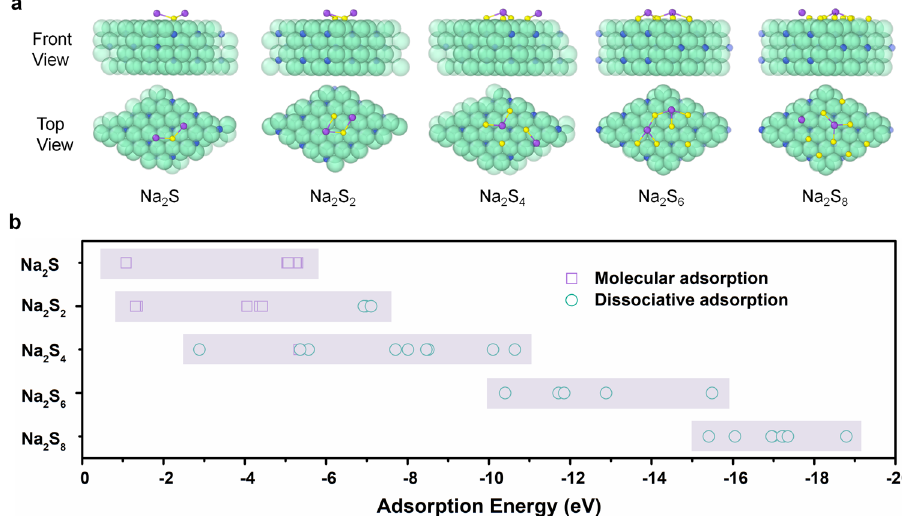
Fig. 3 DFT calculations on the adsorption properties of Fe 3 N. a Typical adsorption con fi gurations of Na 2 S n ( n = 1, 2, 4, 6 and 8) on Fe 3 N. b Calculated adsorption energies of various Na 2 S n ( n = 1, 2, 4, 6 and 8) on Fe 3